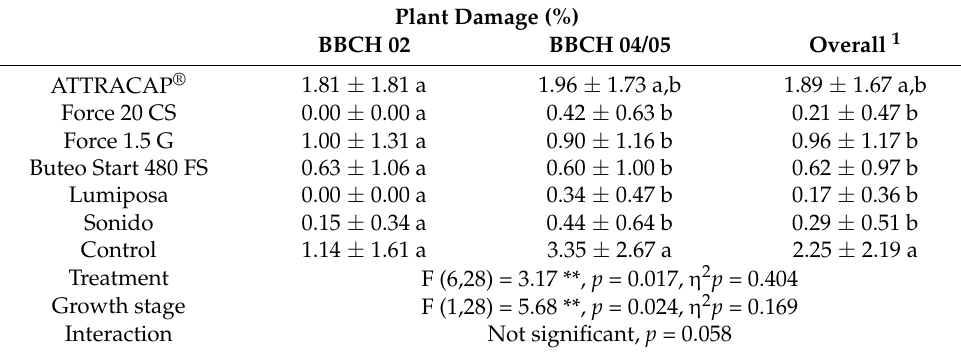
Table 5. Plant damage depending on the insecticidal treatment at RŠ T-12 in 2021.